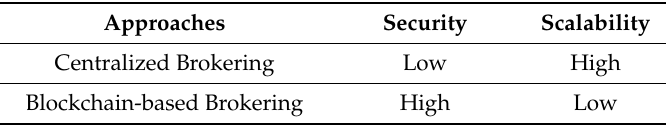
Table 1. Centralized vs. decentralized resource